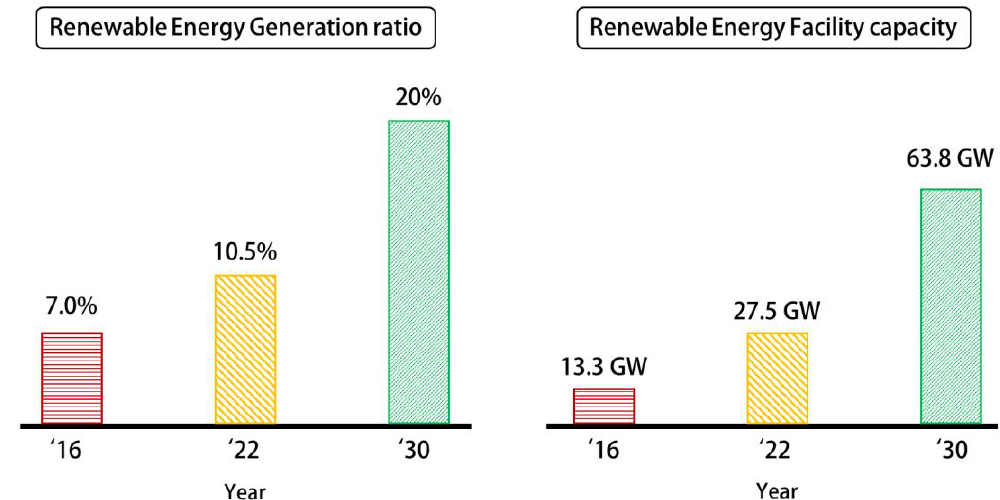
Figure 1. Renewable Energy “3020” Implementation Plan of South Korea.